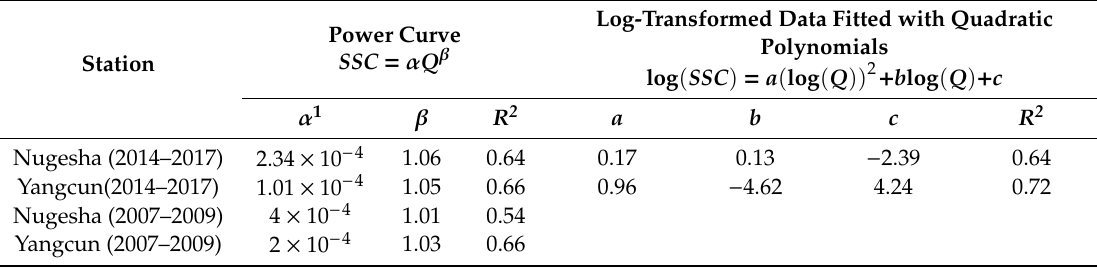
Table 4. Fitting parameters of the sediment rating curve.